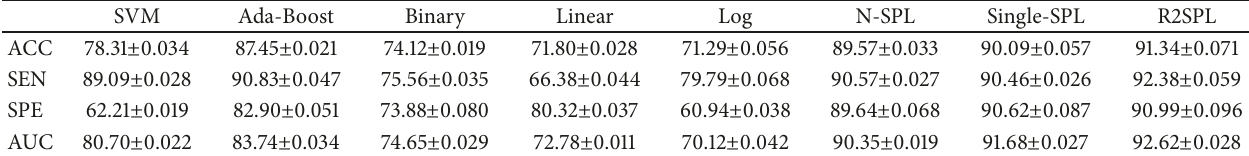
Figure 5: The precision-recall (PR) figures of state-of-the-art methods and our model on 10 UCI databases. Table 3: Results of seven baselines and our model on the task of AD versus HC.